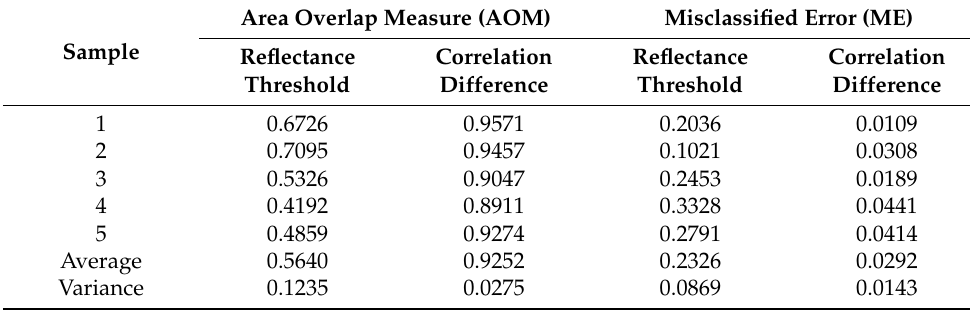
Table 2. Image segmentation performance evaluation.